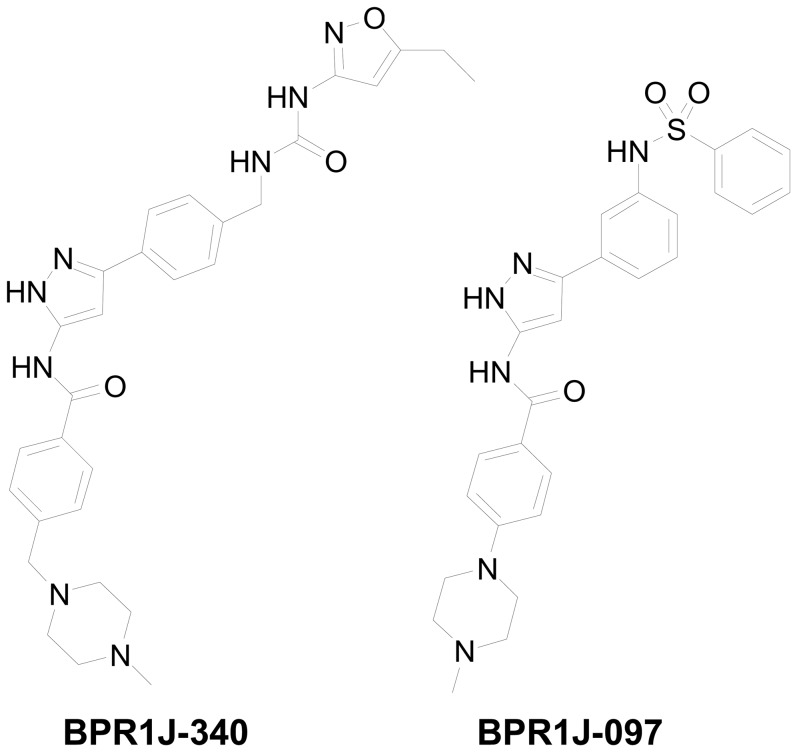
Chemical structure of BPR1J-340 and BPR1J-097.BPR1J-340: N1-(3-4-[([(5-ethyl-3-isoxazolyl)amino]carbonylamino)methyl]phenyl-1H-5-pyrazolyl)-4-[(4-methylpiperazino)methyl]benzamide. BPR1J-097: N1-(3-3-[(phenylsulfonyl)amino]phenyl-1H-5-pyrazolyl)-4-(4-methylpiperazino)benzamide.